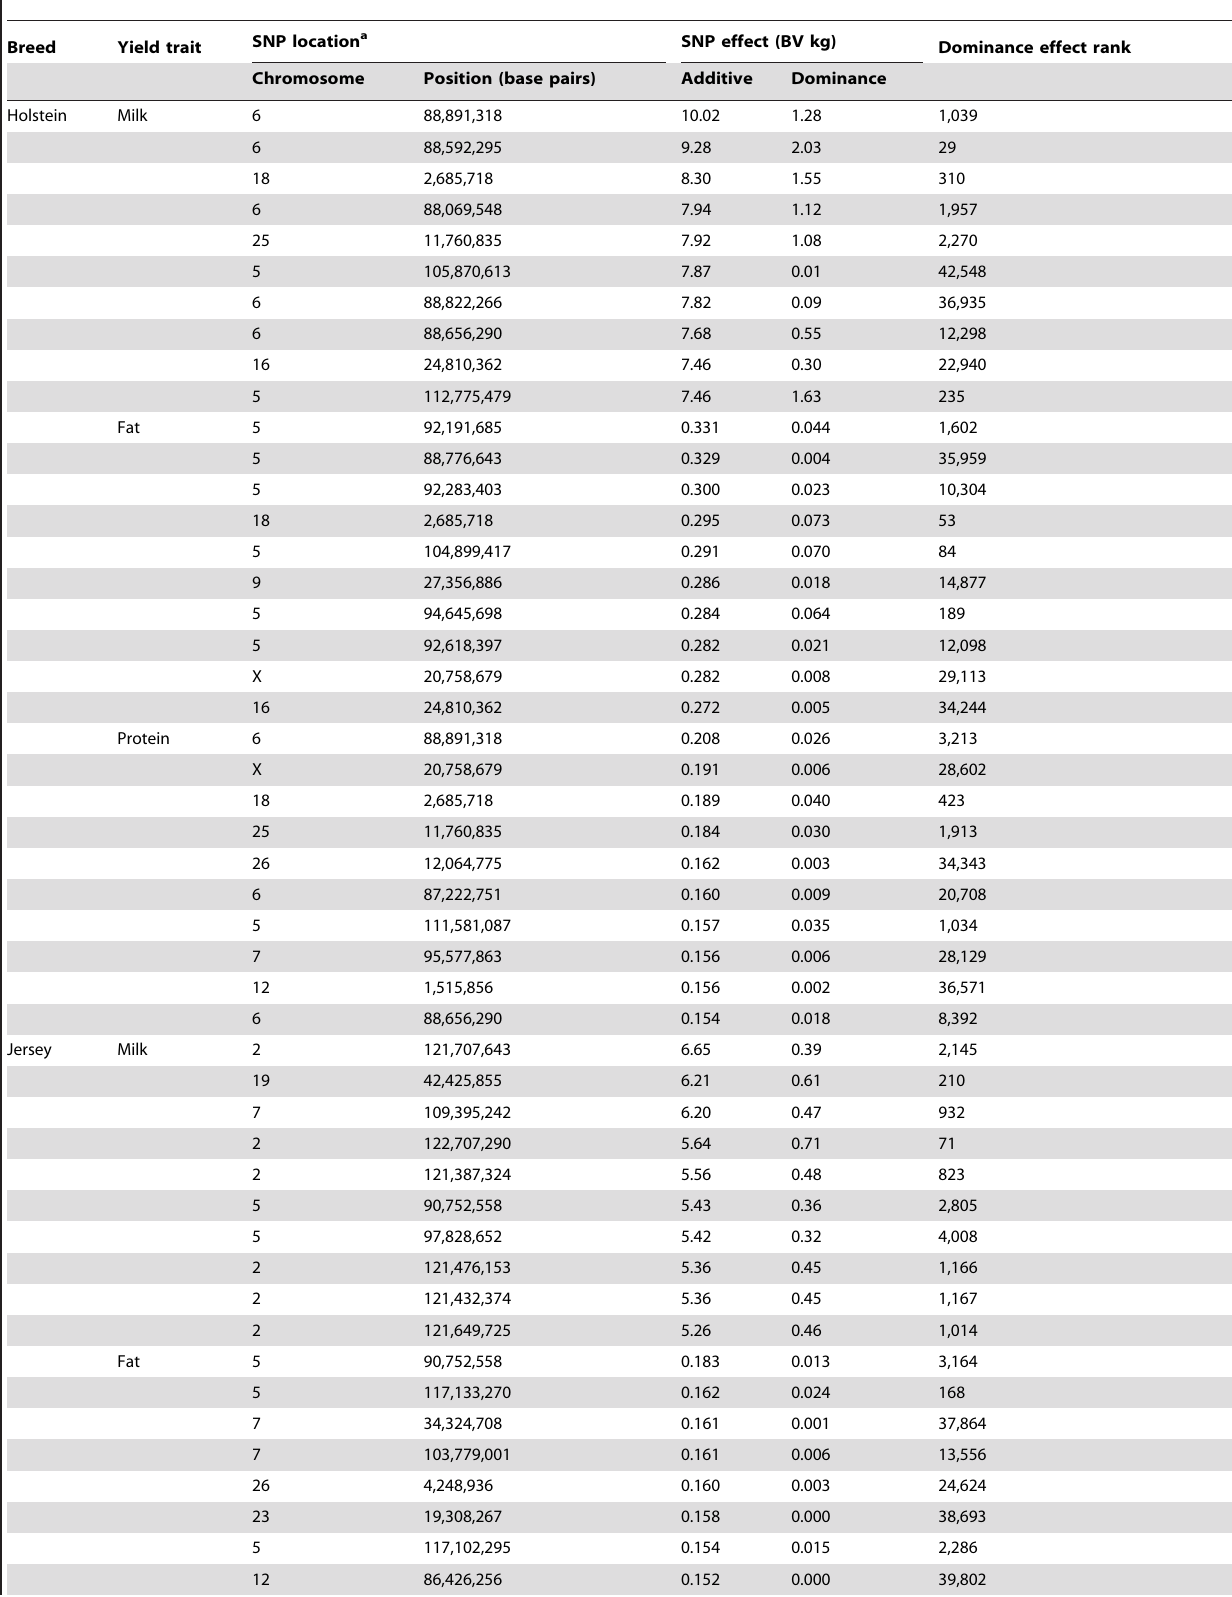
Table 8. Characteristics of top ten single nucleotide polymorphisms with chromosome 14 excluded for Holstein and Jersey milk, fat, and protein yields based on size of additive effect from a model with additive and dominance (values) effects included.